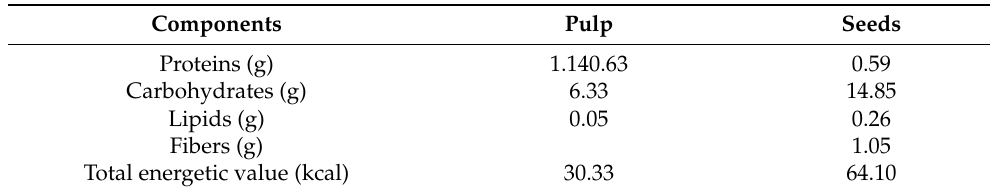
Table 1. Nutritional value of the macronutrients and fibers of E. dysenterica DC. per 100 g, and energy of pulp and seeds